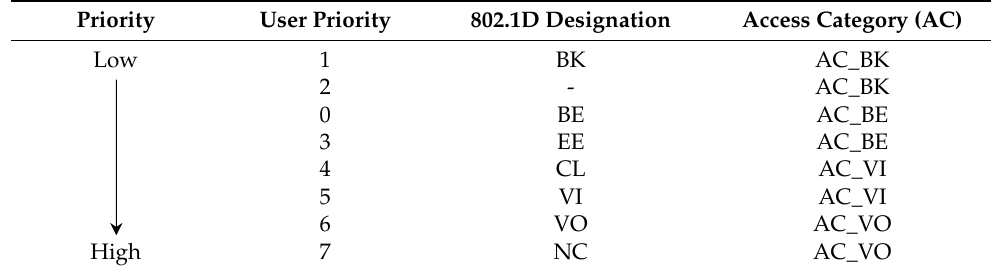
Table 1. According to traffic priority AC classification.